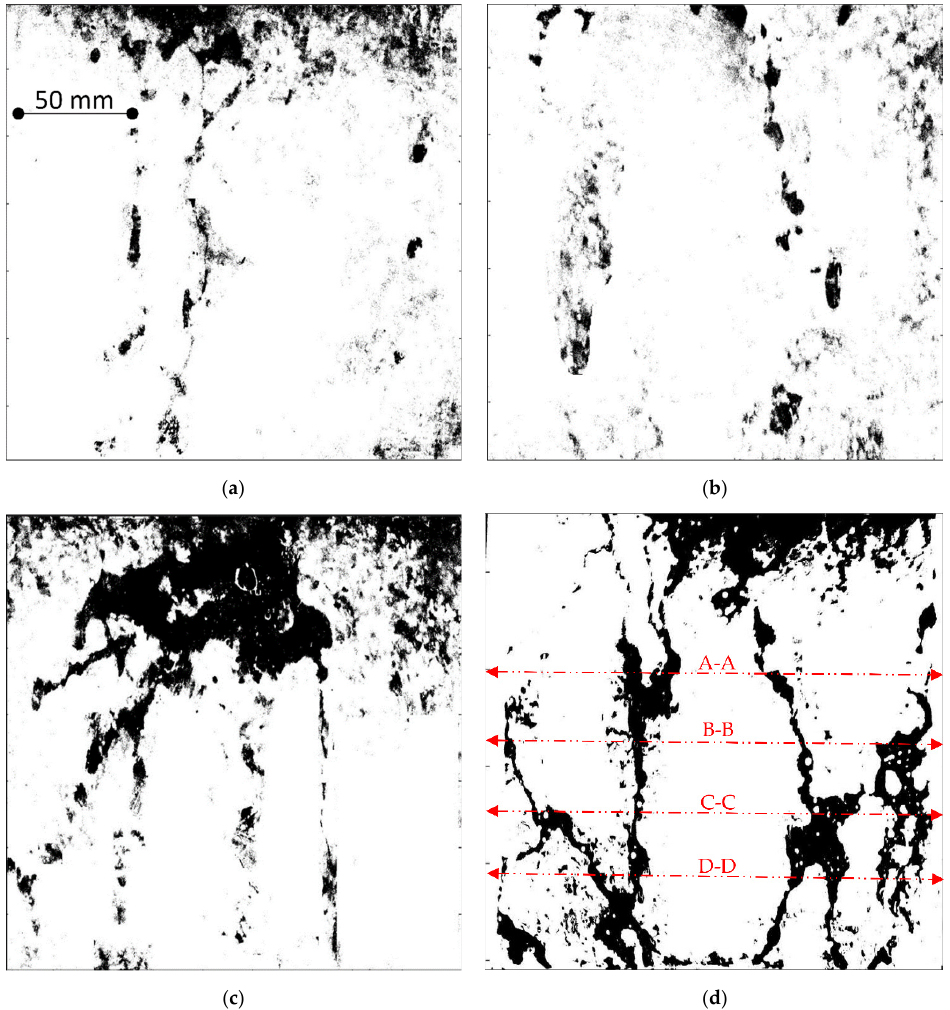
Figure 9. Preferential flow paths in the fractures with different fractal dimensions and mismatch lengths for inclination angle of α = 45 ◦ , 10 min after the start of the infiltration processes in the fracture: ( a ) Fracture-1; ( b ) Fracture-2; ( c ) Fracture-3; ( d ) Fracture-4. As is shown, the flow path distribution for large values of fractal dimension is ho- mogenous; nevertheless, the width of the flow paths and preferential islands can be related to aperture dimension. Figure 10 shows the flow path along Fracture-4 for different cross sections highlighted in Figure 9d. The maximum and minimum width of the flow path oc- cur near the smallest and largest apertures, respectively. Nevertheless, the maximum value of the flow rate is observed in the portion of the flow path close to the largest apertures (red